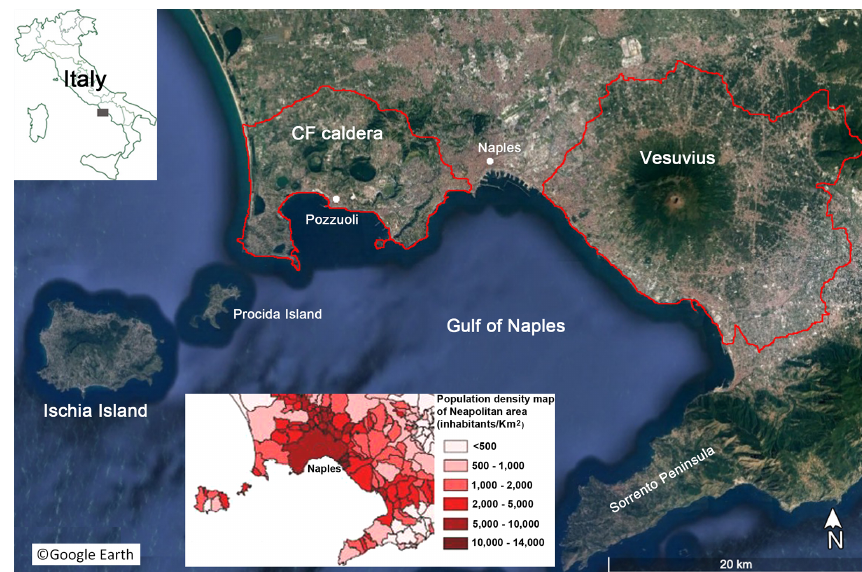
Figure 1. The Neapolitan volcanic area with the three active volcanoes, Vesuvius, Campi Flegrei caldera and the island of Ischia. The limits of the red zones of the evacuation plans for Vesuvius and Campi Flegrei caldera are reported, respectively (from https://www.protezionecivile. gov.it/it/, last access: 20 July 2021). About 1 million people are living in both the red zones. A plan for the island of Ischia is currently in progress (base map is from © Google Earth). The box below shows the inhabitants density map of the Neapolitan area (from http: //www.regione.campania.it, last access: 20 July 2021).